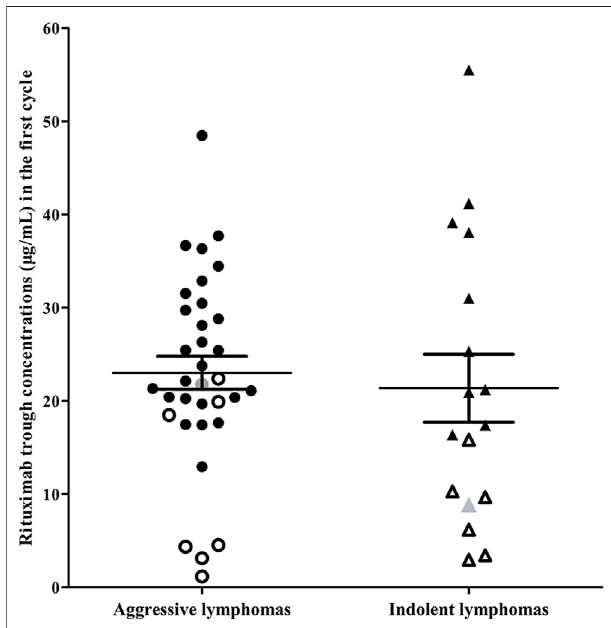
FIGURE 3 | Rituximab concentrations and clinical outcomes of patients intheindolentlymphomagroupandtheaggressivelymphomagroup.Indolent lymphomas (triangle) included marginal zone lymphoma and mantle cell lymphoma classical type with ki-67 ≤ 30%. Aggressive lymphomas (dot) included high-grade B-cell lymphomas, Burkitt lymphoma, unclassi fi able B-cell lymphoma (intermediate between DLBCL and classical Hodgkin ’ s), mixed B-cell lymphoma and mantle cell lymphoma with ki-67 > 30%. Hollow dots or triangles, patients who failed fi rst-line treatment; gray dot or triangle, patients who relapsed after achieving a complete